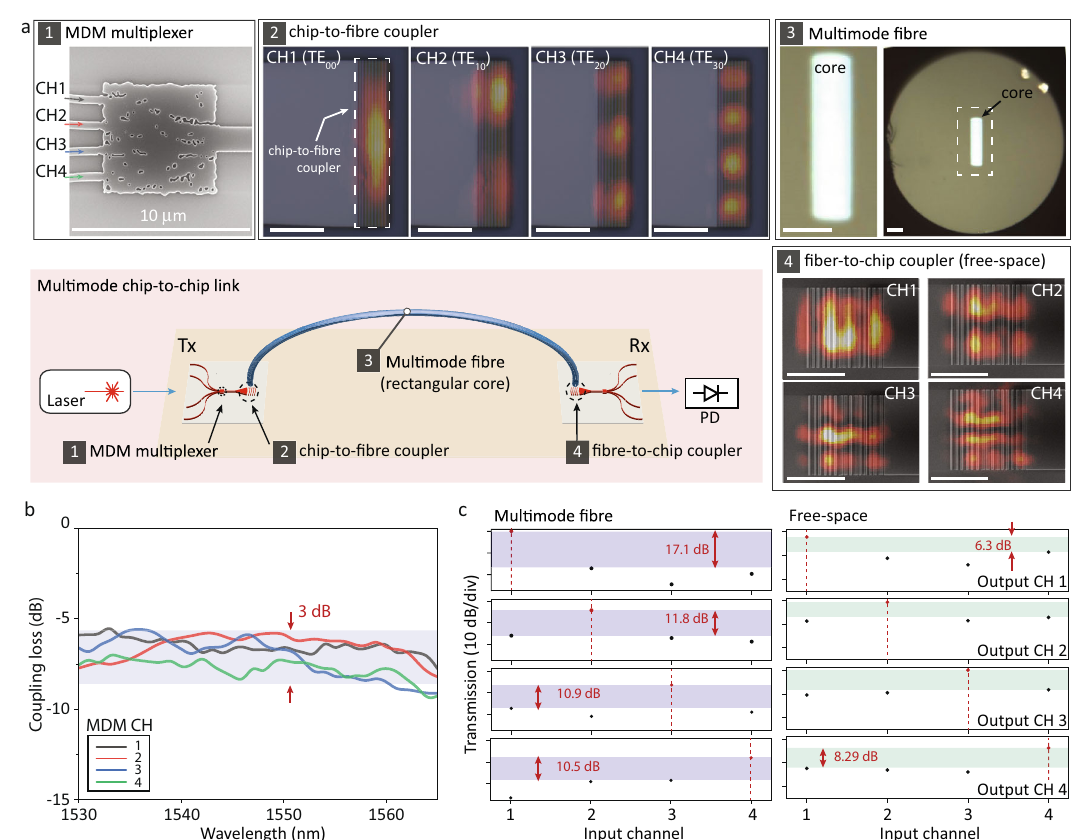
Fig. 4 | Chip-to-chip multimode link using inverse-designed couplers. a Schematic of a multimode link (scale bars: 10 μ m). A CW laser is coupled to an input single-mode waveguide of the Tx chip via a lensed fi bre. The input signal is routed into a speci fi c spatial mode of a multimode waveguide using an MDM multiplexer (Inset 1). Inverse-designed chip-to- fi bre coupler emits the multimode signalinthesurface-normaldirection(Inset2:Infraredimagesofmultimodebeams at the top surface of the device are overlaid on device SEM images), and the mul- timode beams can be coupled to spatial modes of a multimode-matched fi bre (Inset 3: Microscope imageofthe fi brecross-section).The MDMsignalthen issent totheRxchip,androutedintoaspeci fi csingle-modeoutputwaveguideofthechip